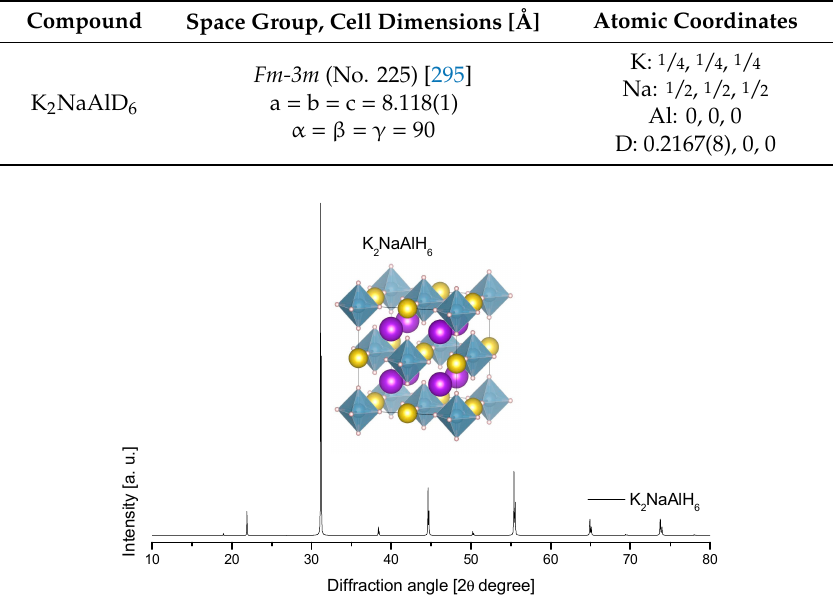
ff raction pattern ( λ = Cu k α 1